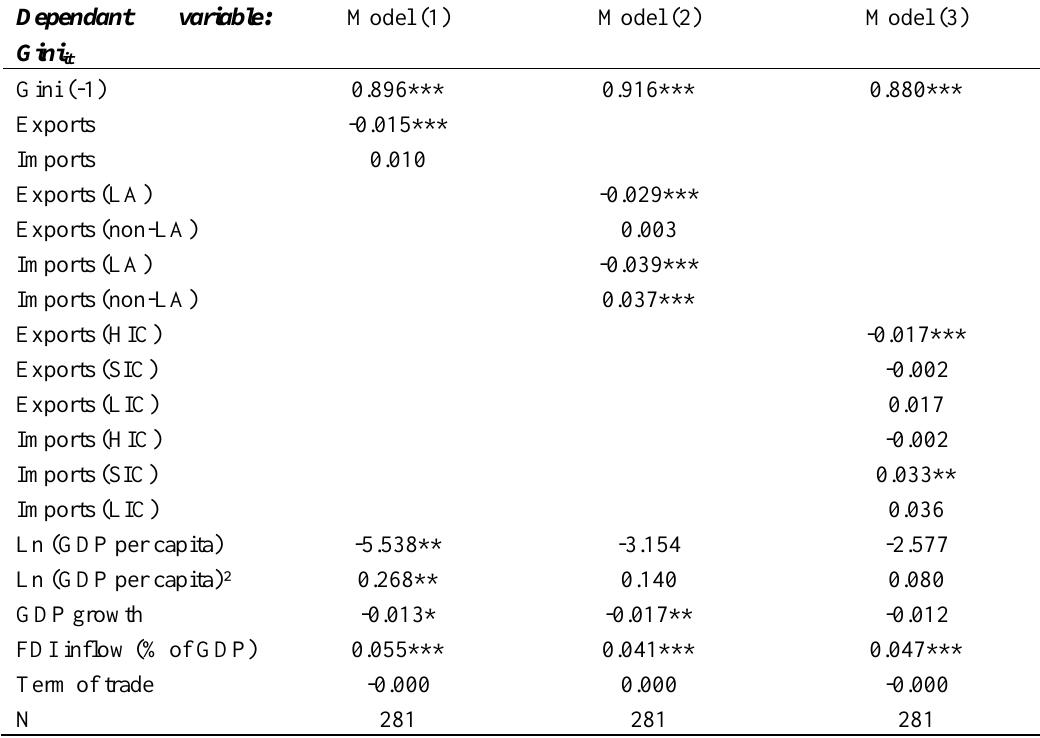
Table 2 : Effects of overall exports and imports (% of GDP) on income inequality Dependant